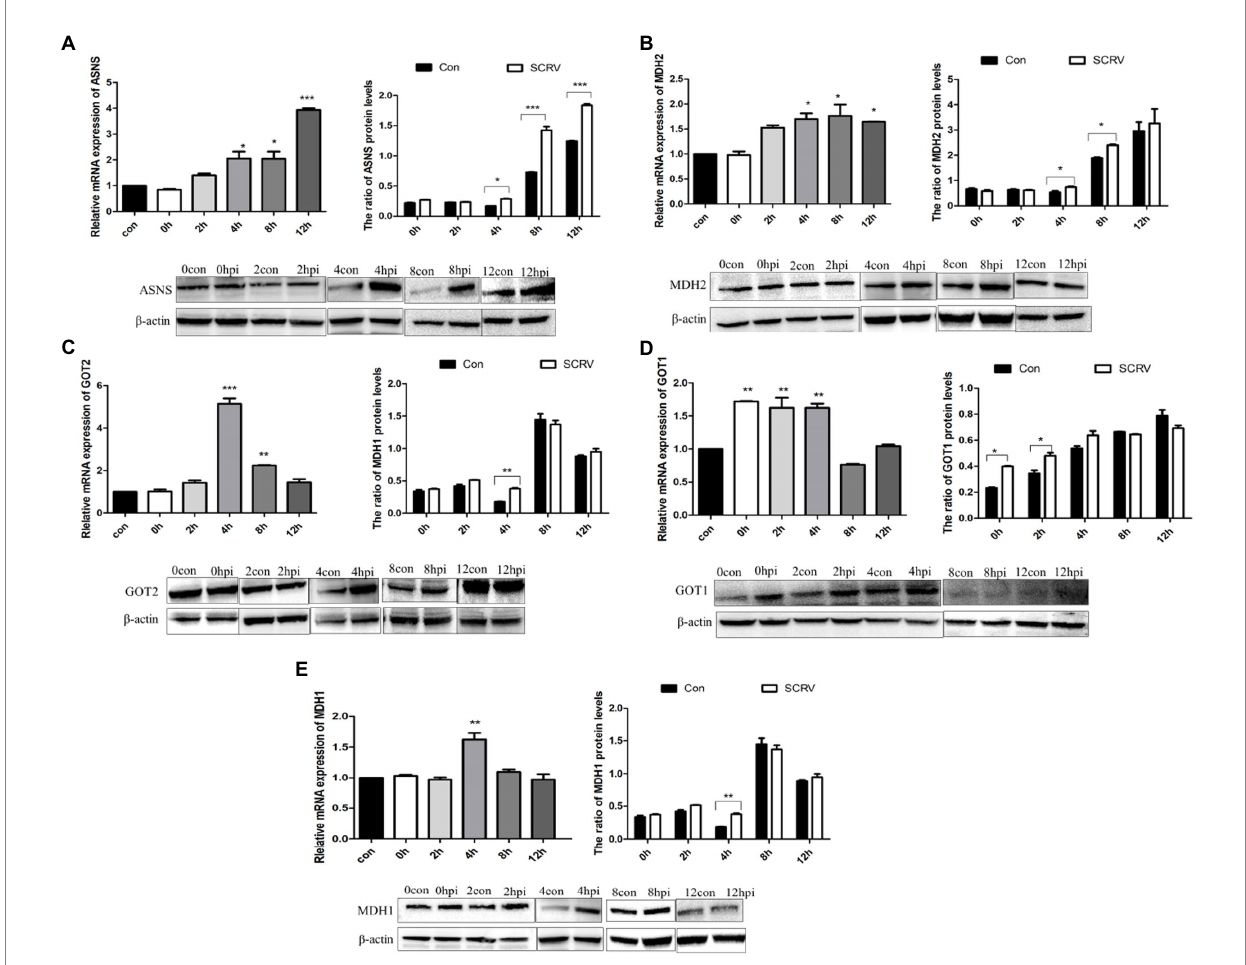
FIGURE 2 SCRV infection altered aspartate metabolism in CPB cells. Cells infected with or without SCRV (MOI = 1.0) were collected at 12, 24, 36, 48, and 72 h for transcript and protein levels analysis. The transcript levels of key enzymes of the aspartate metabolic pathway were compared with the uninfected group. (A) Transcription level and protein level of ASNS, the key enzyme in asparagine biosynthesis pathway ( n = 3). (B–E) Transcript levels and protein levels of the key enzyme genes MDH2, GOT2, GOT1, and MDH1 in the aspartic acid-malate shuttle pathway. ASNS, asparagine synthetase; MDH1/2, malate dehydrogenase 1/2; GOT1/2, glutamic oxalacetate transaminase 1/2; con, control; and hpi, hour post infection. NS, p > 0.05, * p < 0.05, ** p < 0.01, *** p < 0.001 (unpaired Student’s t -test). Data are representative of three different independent experiments (mean ±